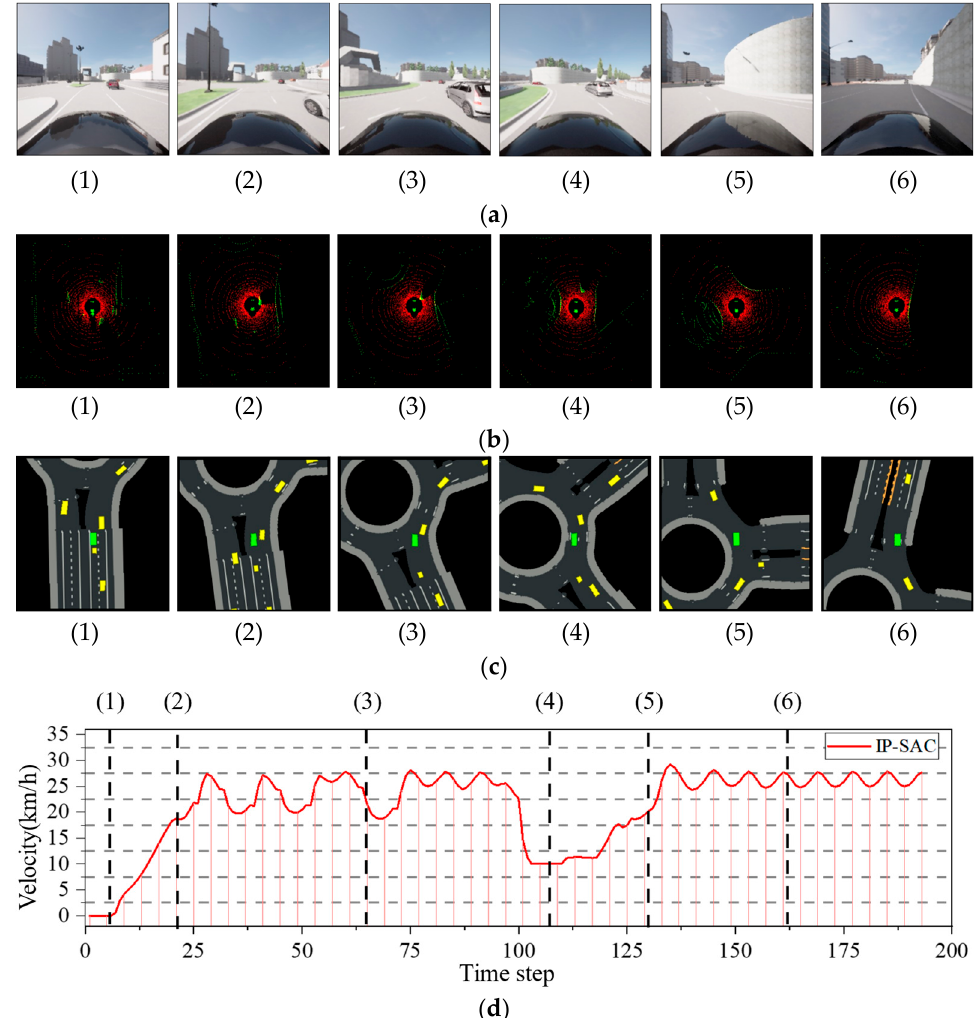
Figure 15. IP-SAC test in CARLA roundabout. ( a ) Ego-vehicle front camera data. ( b ) Ego-vehicle lidar data. ( c ) Projection of other obstacle vehicles’ location and map information. ( d ) Ego-vehicle driving speed curve.